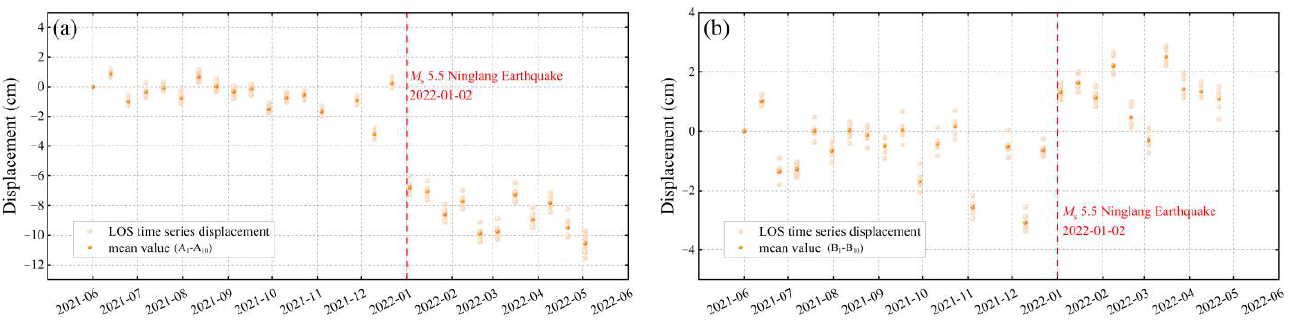
Figure 7. ( a ) The deformation time series at point A 1 to point A 10 ; ( b ) The deformation time series at point B 1 to point B 10 .